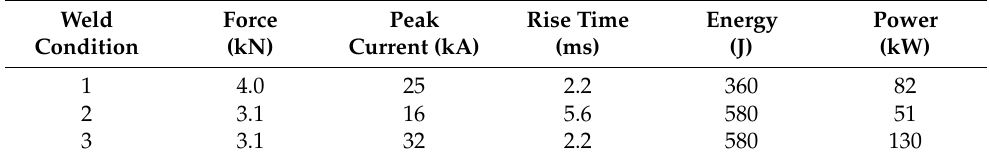
Figure 1. ( a ) A solid-state joint is formed from simultaneous pressure and resistive heating at a narrow contact point, shown in cross-section. ( b ) Representative pulse current and cap displacement measured during CDRW. Note that cap movement is delayed versus current, reflecting the time for material to heat and soften, and finishes before the pulse completely dissipates, indicating that the remaining current is insufficient to heat the broadened contact and sustain flow. Table 2. Weld conditions for CDRW of 14YWT.